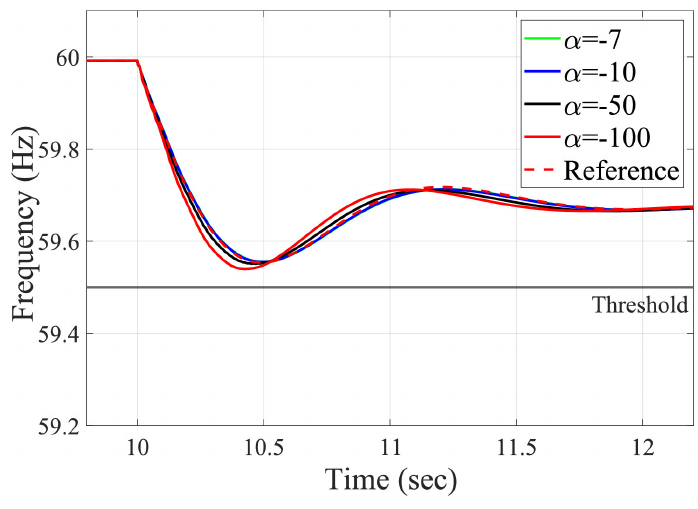
Figure 23. Frequency response for different values of α .